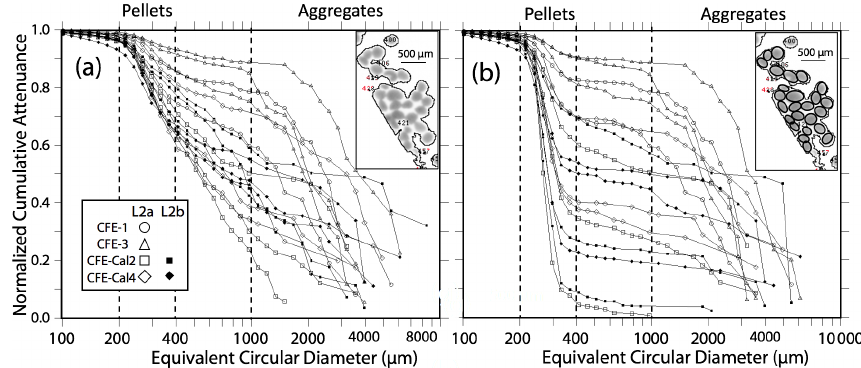
Figure 7. Processed size distribution data for CFE-1–4 deployed near 150m at L2. Normalized cumulative attenuance flux is plotted against equivalent circular diameter (µm). (a) Original cumulative attenuance size distributions from ImageJ and (b) after secondary processing to correct for touching particles (see insets in upper right-hand corners of a and b ). Boundaries for reduced size categories are 30–100 (not shown), 100–200, 200–400, 400–1000, and > 1000µm and are indicated in (a) and (b) . Open and closed symbols denote data from the first and second deployments of the CFE-Cals at location 2 designated as L2a and L2b, respectively. After correction, the 400–1000µm size category contributed little to sample